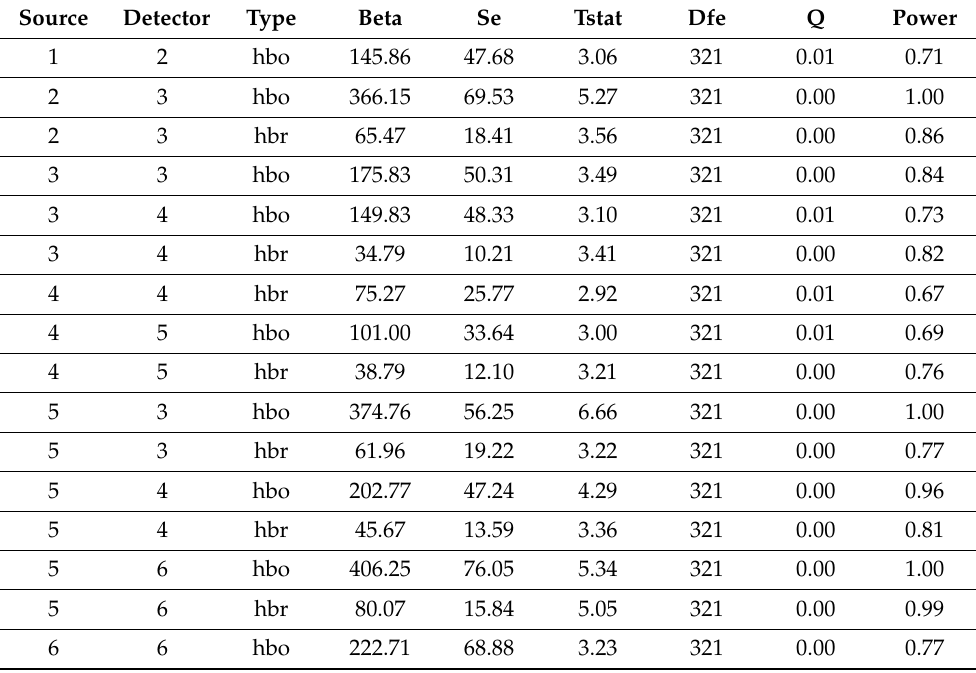
Table A5. t -test statistics for each channel (source–detector pair).